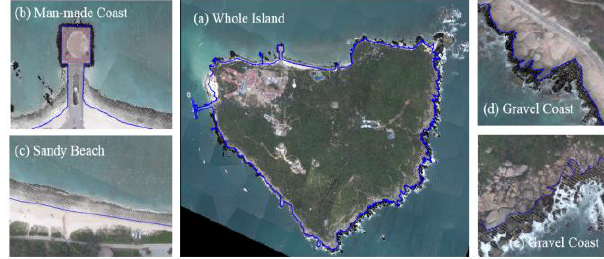
By fitting all sandy beach point cloud to a plane and having it intersected with the ground surface, we had the results as below (Figure 13): the black points under the blue line indicated the points higher than water surface profile but lower than the shoreline, which had a relatively high intensity value.